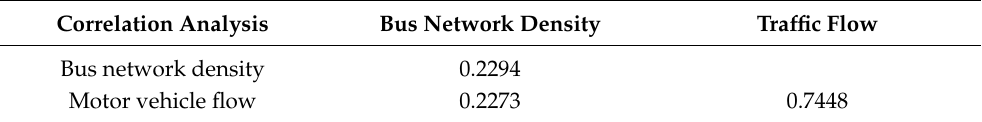
Table 8. Interaction detection